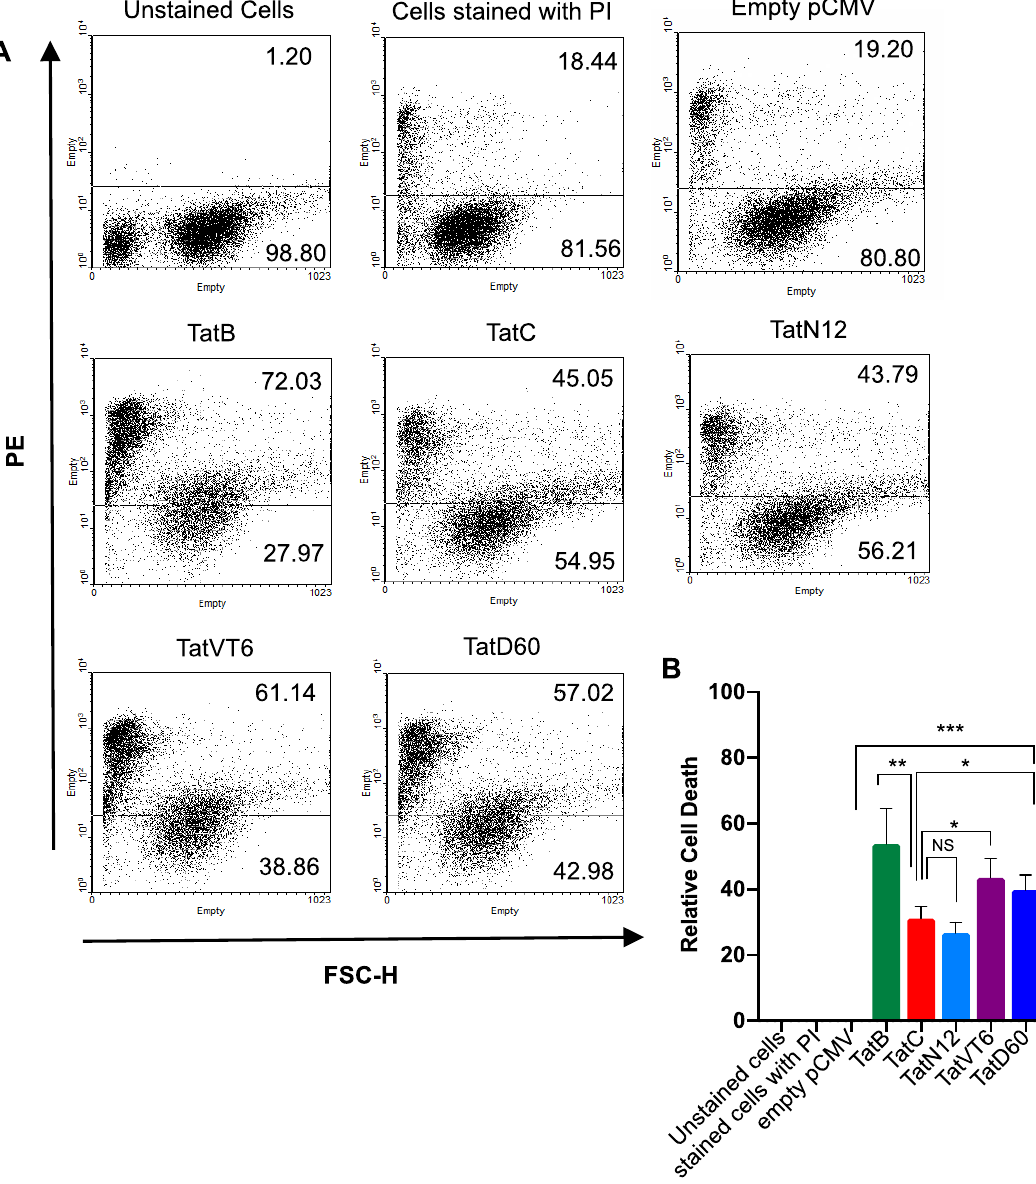
Figure 4. Tat subtypes and variants induced cell death in HEK293T cells. Panel ( A and B ) HEK293T cells (1 µ g plasmid DNA / well in 1 × 10 6 cells) were transfected with Tat variants (TatN12 or TatVT6 or TatD60) or Tat subtypes (TatB or TatC) or empty pCMV-Myc vector. After 24 h of transfection, cells were stained with PI (10 µ g / mL) for 20 to 30 mins on Ice under dark condition. The flow cytometry (BD-LSRII) was performed to determine cell death and the data was analyzed using FlowJo 10.3 software. PI stained cells fall in the PE channel. In the plot, the X-axis represents FSC-H and the Y-axis represents PE. The un-stained cells were used as a control to make gating for the transfected cells. The cells treated with empty pCMV-Myc vector were used as a control to show that there was no e ff ect of our expression pCMV-Myc vector in causing cell death. The relative cell death of Tat variants was measured by subtracting empty pCMV-Myc vector values. Multiple-group comparisons were performed using one-way analysis of variance (ANOVA) followed by student t -test and are presented as mean ± S.E.M. *** Highly significant ( p < 0.0005), ** moderately significant ( p < 0.005), * significant ( p < 0.05), NS is non-significant. All experiments were repeated three times.